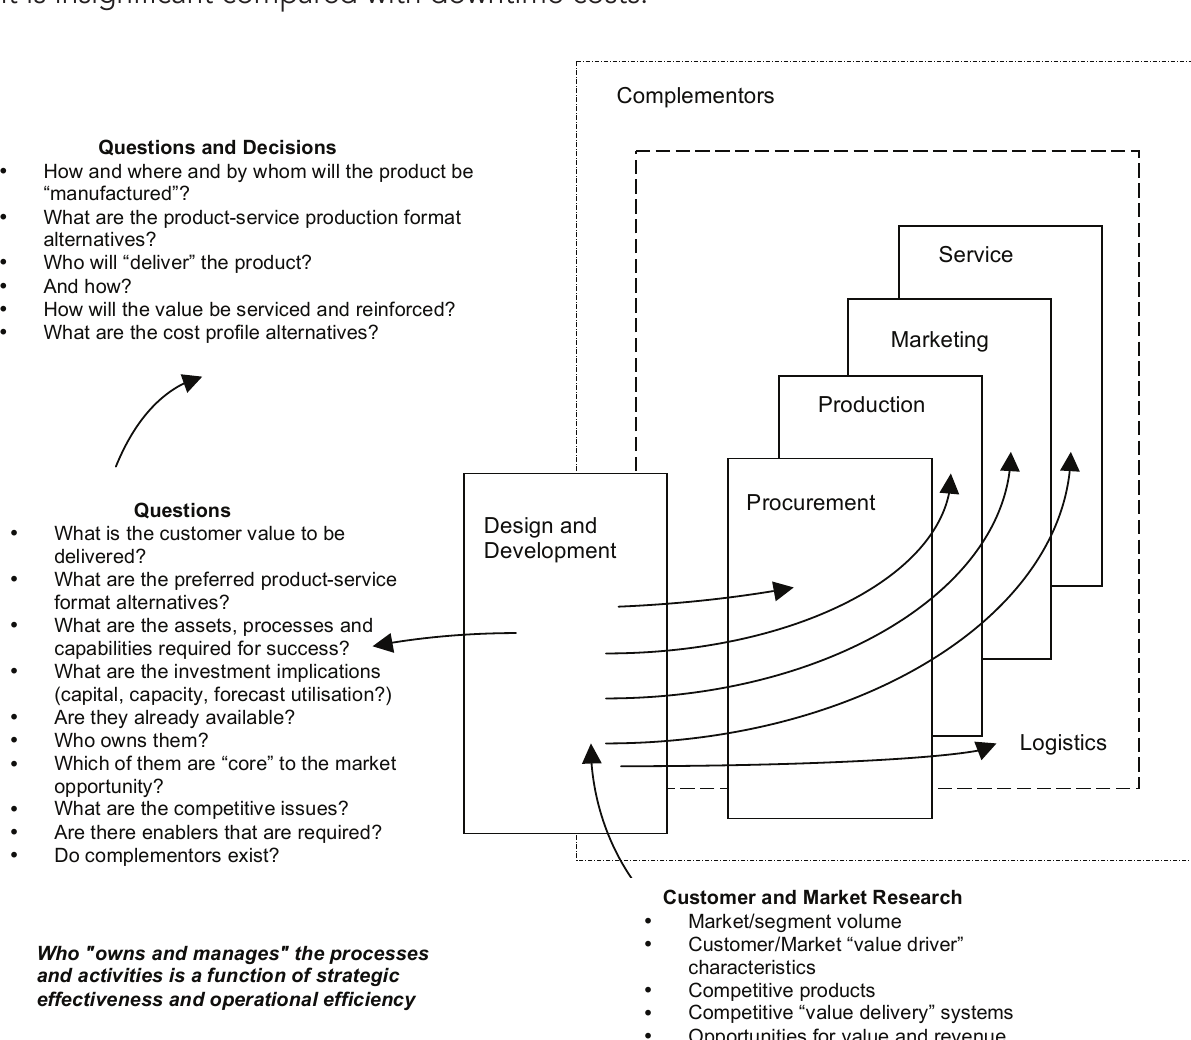
Customer and Market Research •